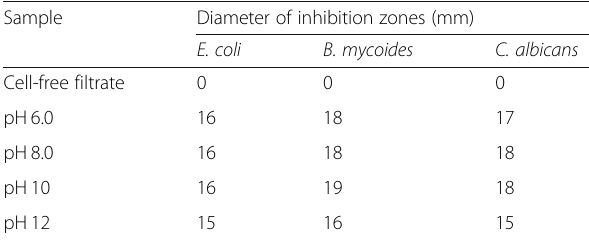
Table 1 Antimicrobial activity of the AgNPs biosynthesized by means of A. fumigatus CFF mediation Sample